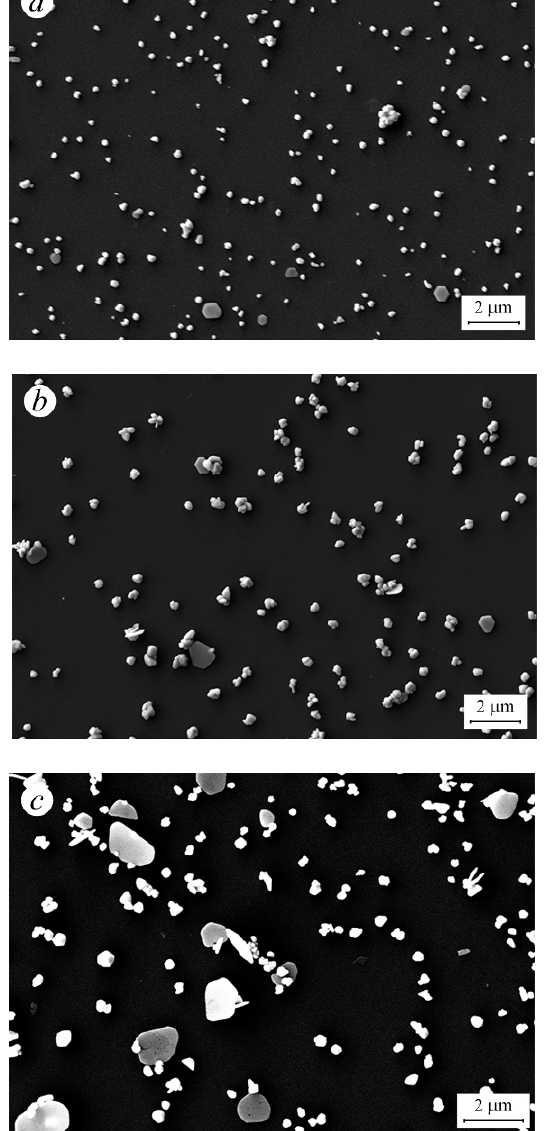
Figure 2. SEM-images of ITO-glass surface after silver electrode- position in acetonitrile solution of 0.01 M AgNO E = –1.0 V during 15 (a), 25 (b) and 50 (c) s. Depositions were carried out by pulse electrolysis under τ τ = 190 ms. off be the consequence of the ohmic drop, since the ion concentration is low and no supporting electrolyte was used. At higher potentials the rate of silver reduction increases too. That was showed by SEM images in Fig. 1 as an increment of the number of silver particles formed on ІТО-glass surface. That tendency is motivated by kinetic control of nucleation process and obviously it is typical behavior under metal electrodeposition [5].